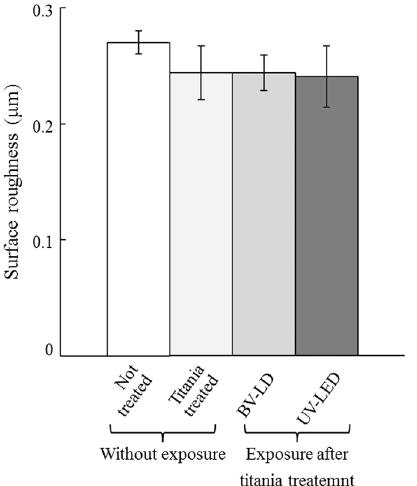
Figure 1. Changes in the average surface roughness of each specimen.